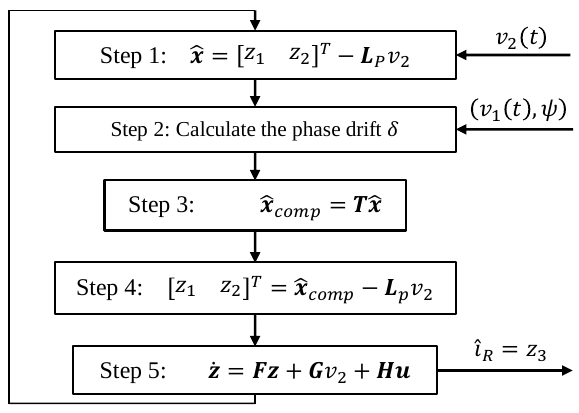
Figure 5. Vector rotation for compensating the phase drift.